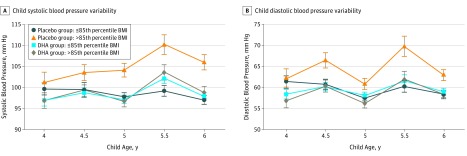
Systolic and Diastolic Blood Pressure at Each Age by Maternal Docosahexaenoic Acid (DHA) RandomizationBMI indicates body mass index. Error bars indicate SE